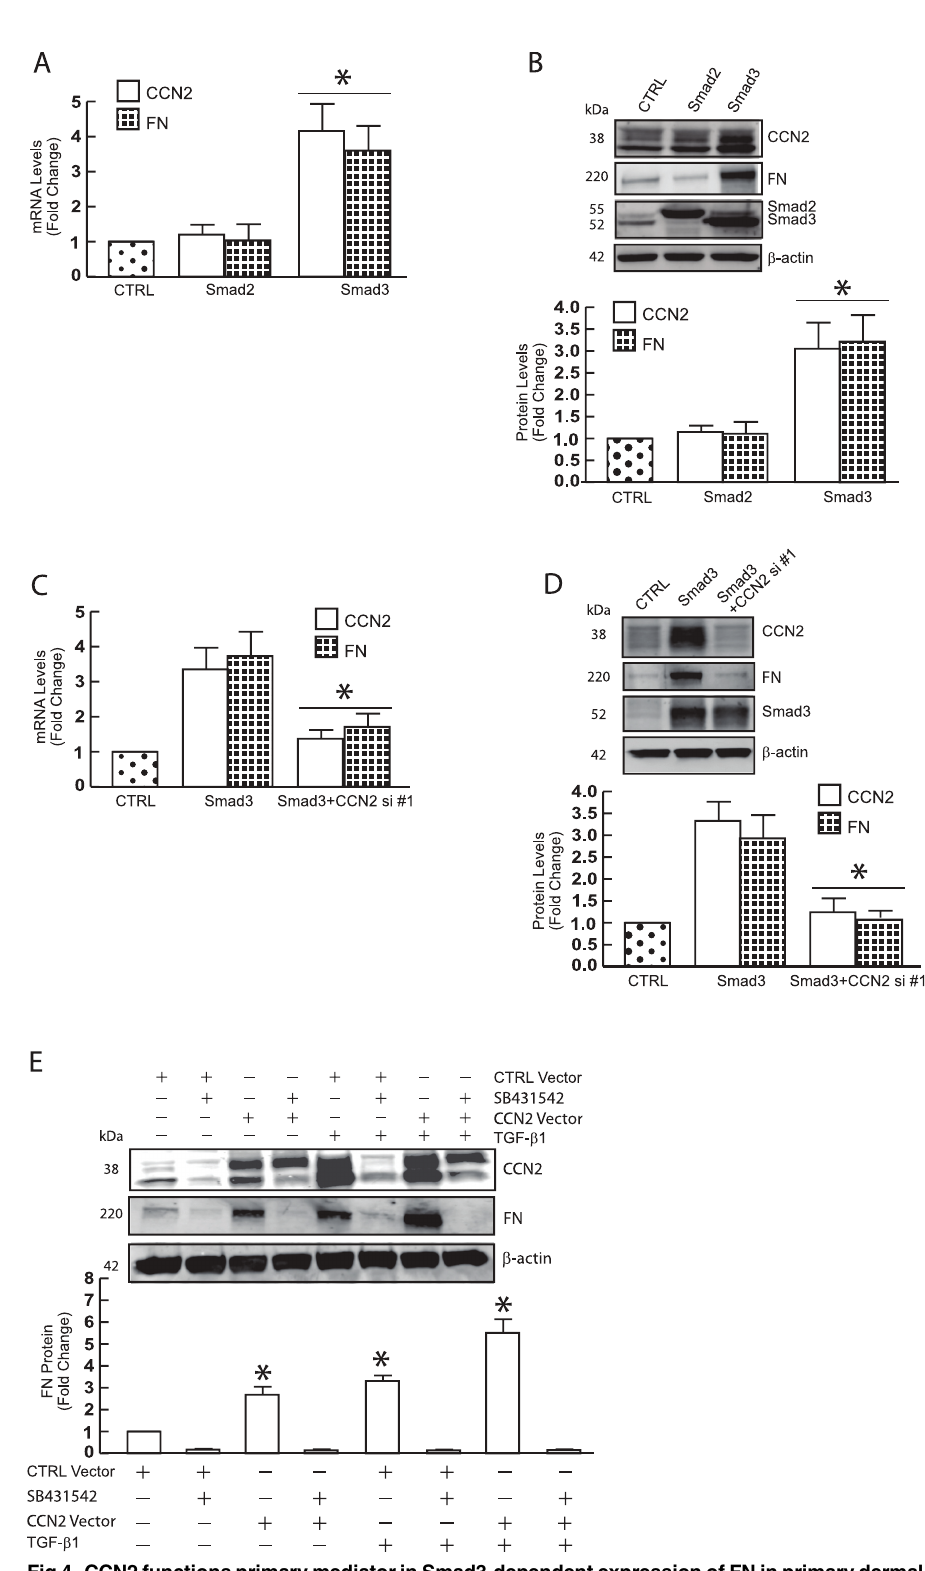
Fig 4. CCN2 functions primary mediator in Smad3-dependent expression of FN in primary dermal fibroblasts. Primary dermal fibroblasts (1 × 10 6 ) were transfected with the indicatedsiRNAs (20nM) and vectors (1 μ g). Total RNA and whole cell extract were prepared48 hours after transfection. mRNA and protein levels were quantified by real-time RT-PCR and Western analysis, respectively. mRNA levels